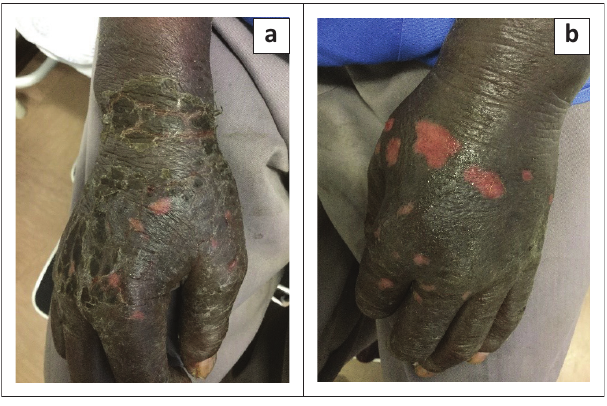
FIGURE 3: Sub-acute contact dermatitis secondary to the usage of latex gloves, characterised by erosions, swelling and